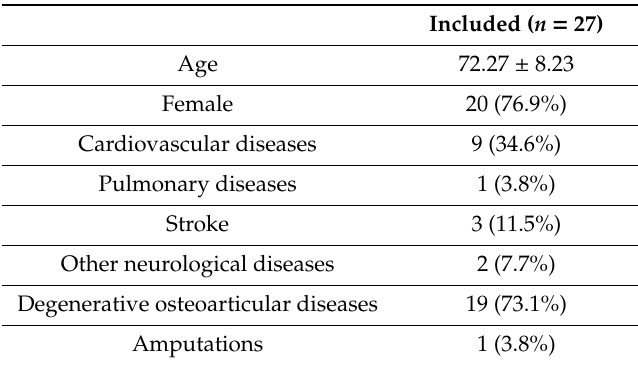
Table 2. The demographic details of the study